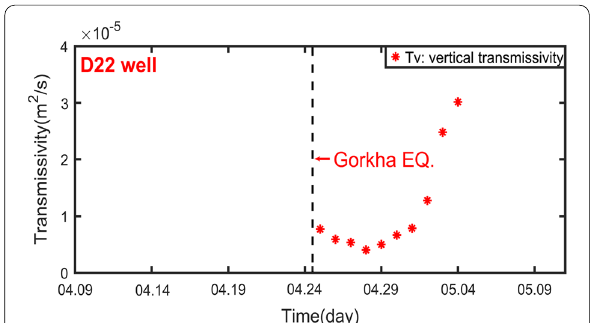
Fig. 9 Time-dependent transmissivity of the D22 well based on M2 tide analysis. Dotted line shows the origin time of 2015 Gorkha earthquake. Tv is calculated from the vertical pore-pressure diffusion